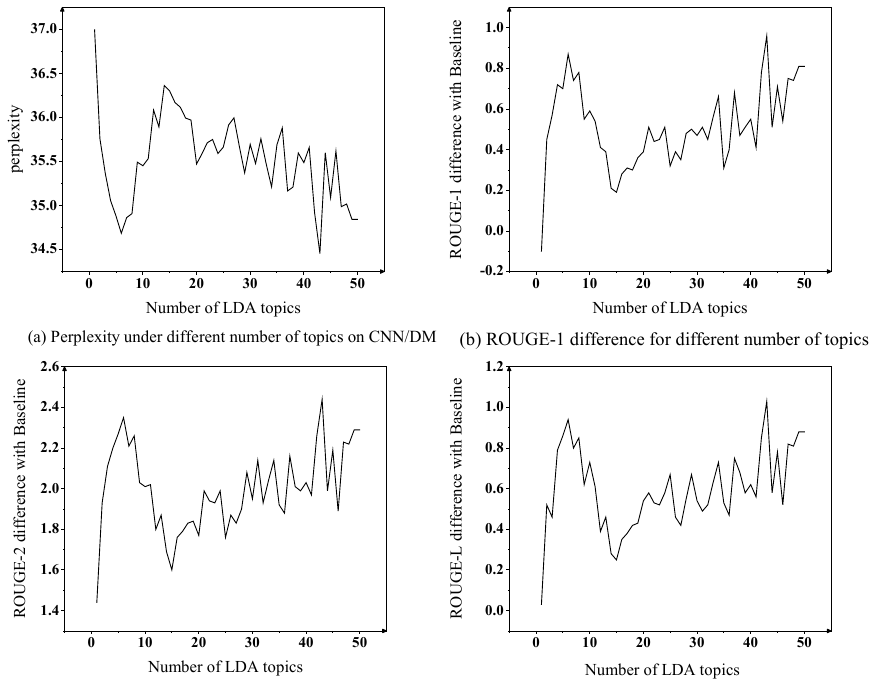
Figure 7. Correlation of summary quality with the number of topics in CNN/DM dataset, where, figure ( a ) shows the variation of perplexity with the number of topics. In figure( b – d ) the vertical axis represents the ROUGE difference between ACGT and the baseline model [4].